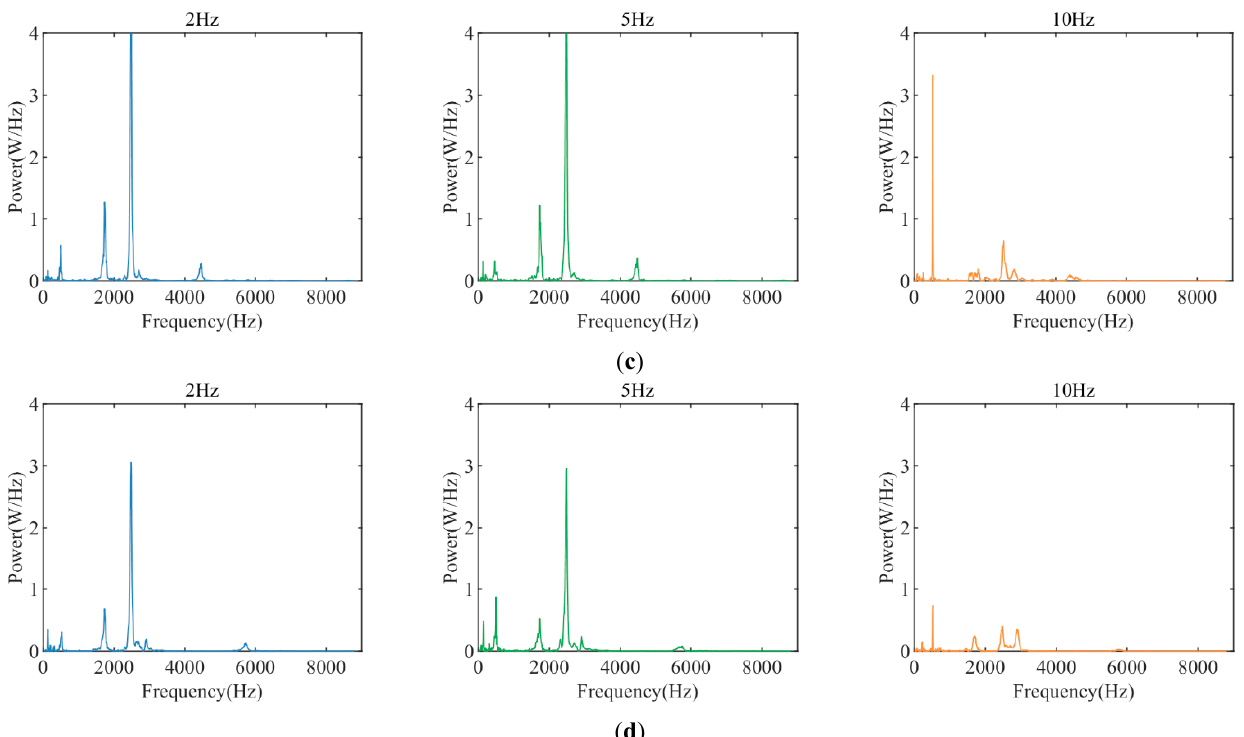
Figure 10. Twelve typical acoustic analyses of four-category under three frequency hammerings ( a ) Condition 1: Healthy area; ( b ) Condition 2: Surface damage area; ( c ) Condition 3: Internal damage area; ( d ) Condition 4: Compound damage area.